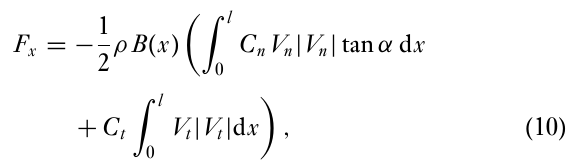
(cid:4) V n , normal speed of fin (cid:4) V t , tangent speed of fin surface